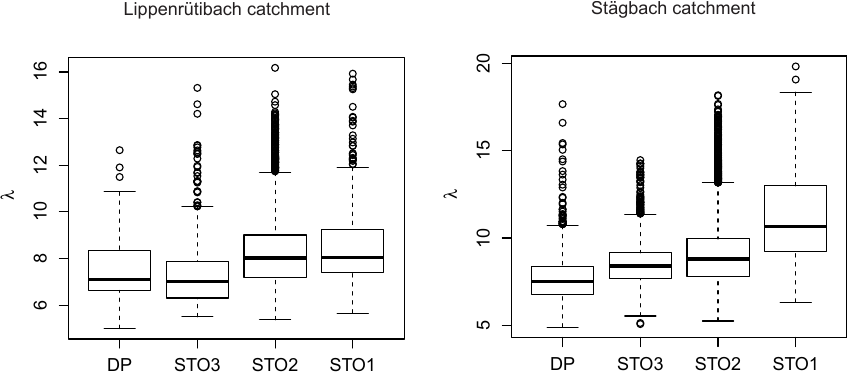
Figure 4. Box plots – the distribution of the topographic index λ within the DoRP storage classes. DP – deep percolation, STO1 – low storage capacity, STO2 – intermediate storage capacity, STO3 – high storage capacity.